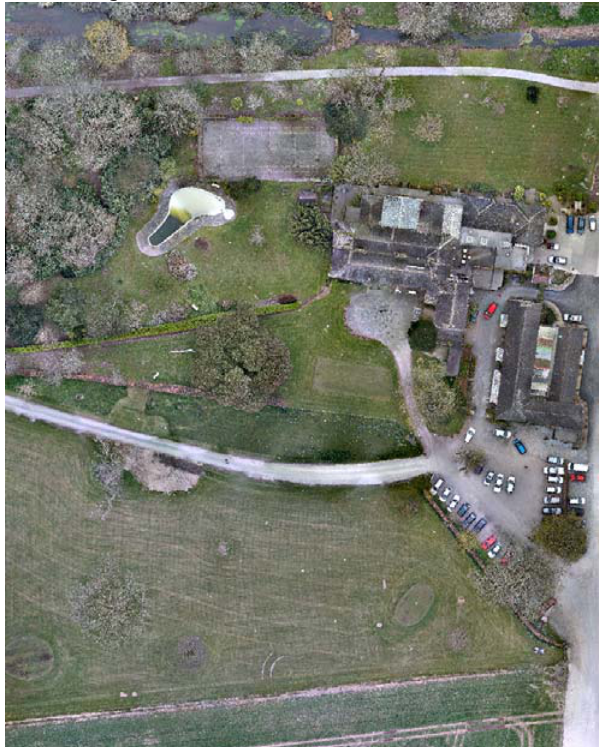
Figure 12: The outputted